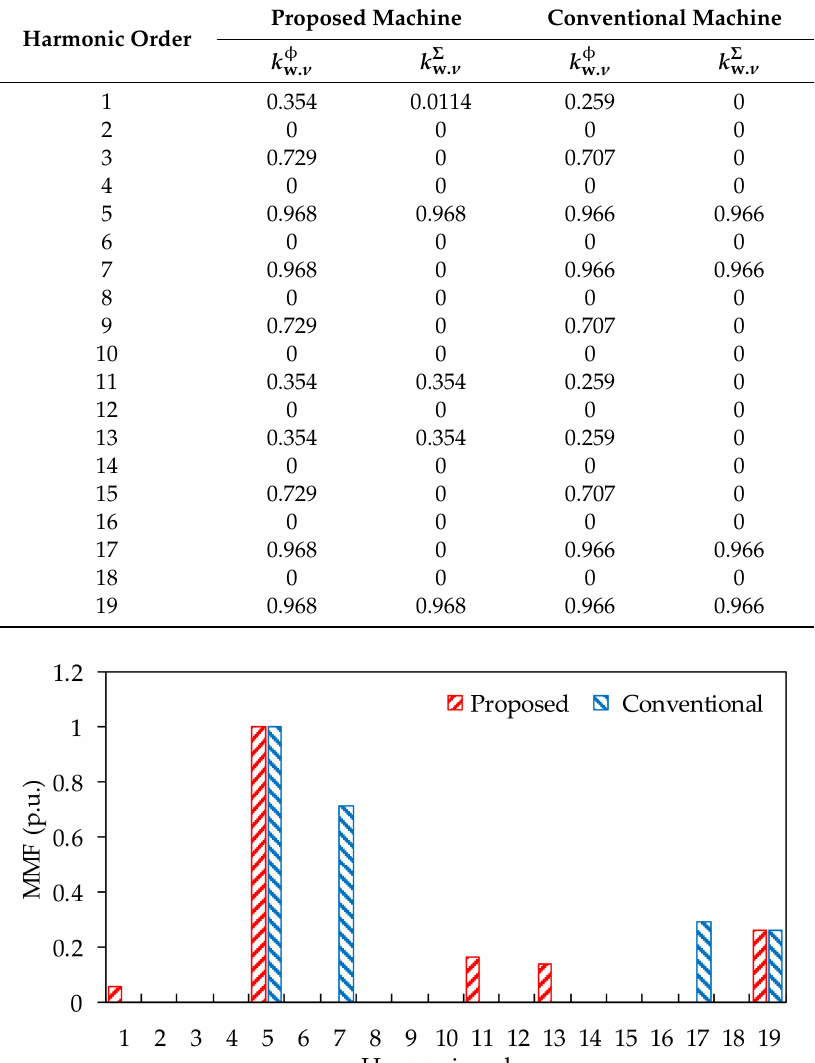
Table 2. Winding factors of the two compared machines.